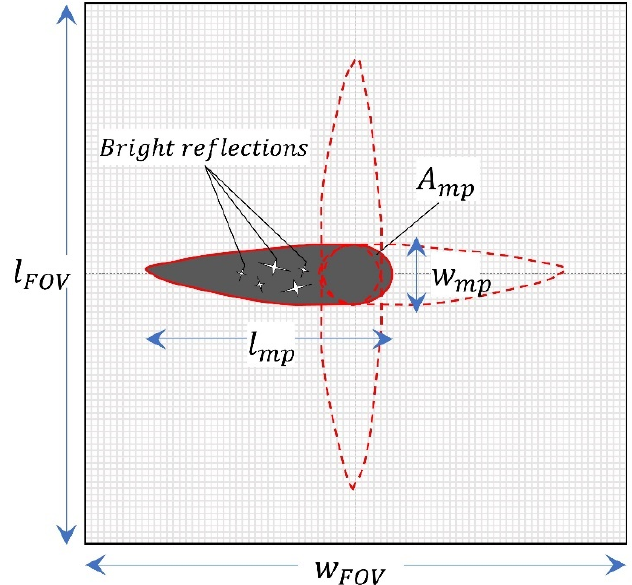
Figure 1. Schematic representation of an acquisition of the melt pool with the imaging chain in coaxial configuration. The geometrical characteristics of the surface of the molten pool are indicated alongside the bright reflections which occur behind the laser–material interaction position generated by the illumination.